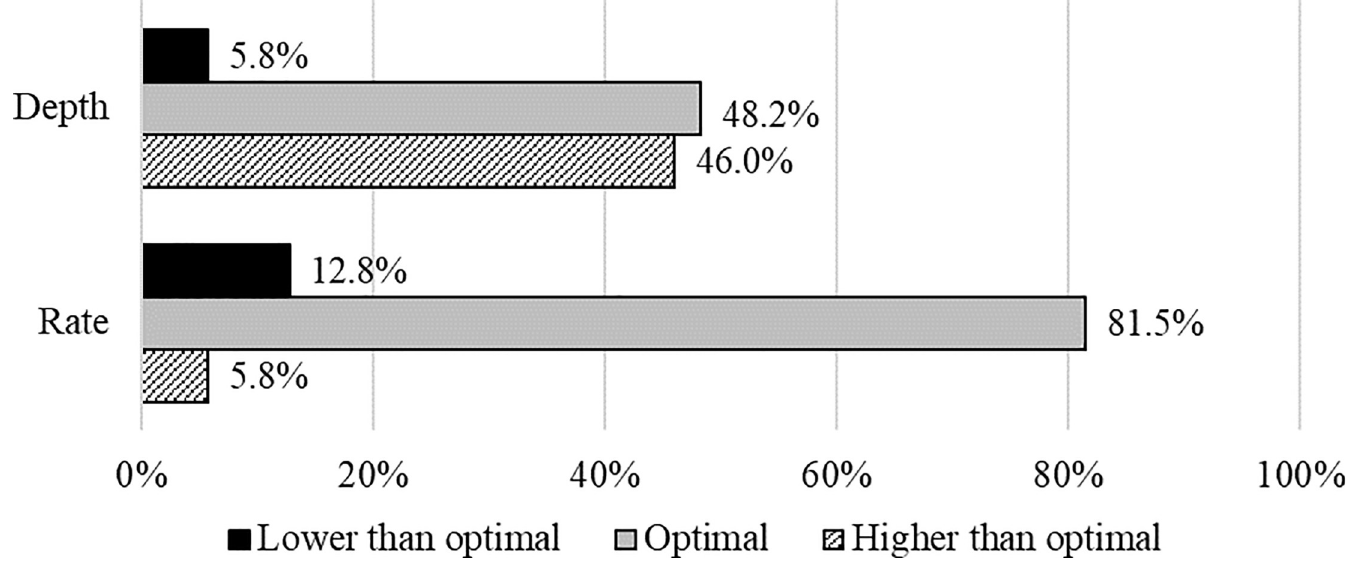
Fig 6. Percentage of chest compressions with optimal rate and depth.